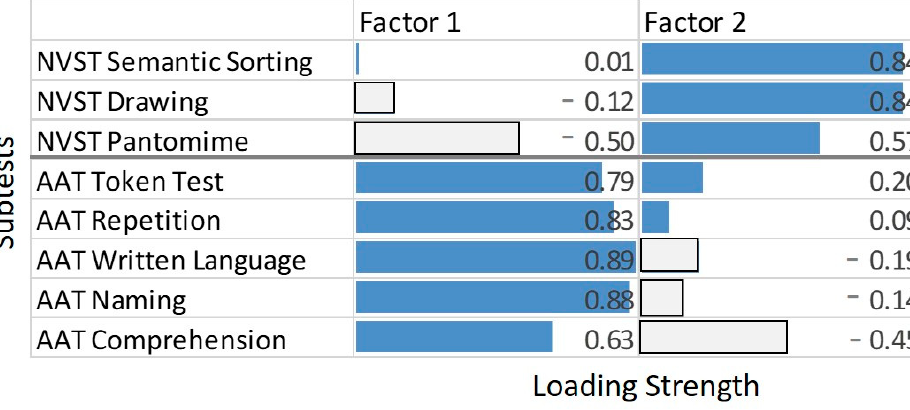
Figure 3. Principal component analysis (PCA) results. The two panels display the factor loadings (absolute values) of each task on the two factors. Dark shaded bars represent indicators with absolute loadings >0.50. Factor 1 explained 44% and factor 2 25% of the variance in the data.